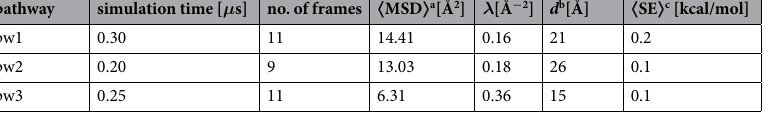
Table 1. Reaction coordinates representing 3 pathways of the camphor diffusion from the cytochrome P450cam active site. a Mean-square deviation of the displacement set. b Distance between the center of mass of camphor and Fe. c Mean standard error of free energy along the pathway after 100 ns of the